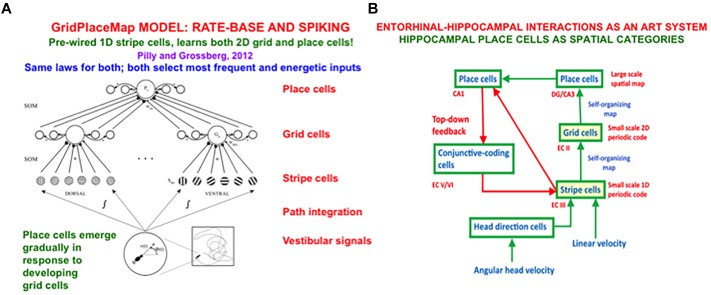
(A) The GridPlaceMap model circuit for spatial representation defines a hierarchy of self-organizing maps (SOM) that learns both grid cell and place cell maps. Stripe cells (Sdas) in the deeper layer of medial entorhinal cortex (MEC), self-organizing grid cells (Gjs) in layer II of MEC, and self-organizing place cells (Pk) in hippocampal area CA3 learn to represent increasingly large spaces in response to internally generated signals based on vestibular linear velocity and angular velocity signals that are activated by navigational movements through the environment. Notice bigger stripe fields and spacings going from dorsal to ventral locations in the model organization. [Adapted with permission from Pilly and Grossberg (2012)]. (B) The hierarchy of self-organizing maps that learn grid cell and place cell maps is part of an ART system in which top-down feedback from place cells to stripe cells can dynamically stabilize the learned grid and place fields. See the text for details.